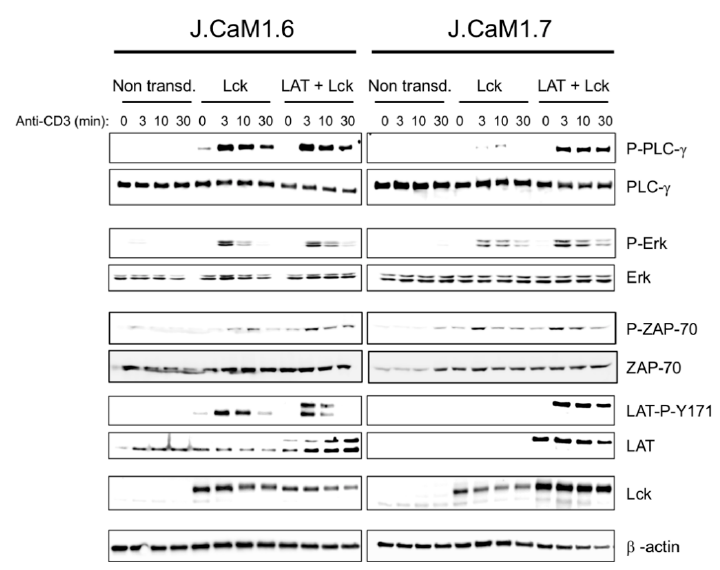
Figure 7. Simultaneous expression of LAT and Lck is necessary for the restoration of the intracellular signals associated with the TCR/CD3 complex in J.CaM1.7 cells. Immunoblot analysis of J.CaM1.6 (left panels) and J.CaM1.7 cells (right panels), non-transduced, or lentivirally transduced with vectors coding for Lck or LAT and Lck, as depicted. Whole-cell lysates were obtained after stimulation with an anti-CD3 antibody (OKT3, 1 μ g/mL) for the indicated incubation times. β - actin immunoblots were performed to show equal protein expression. Images are representative of at least three experiments.